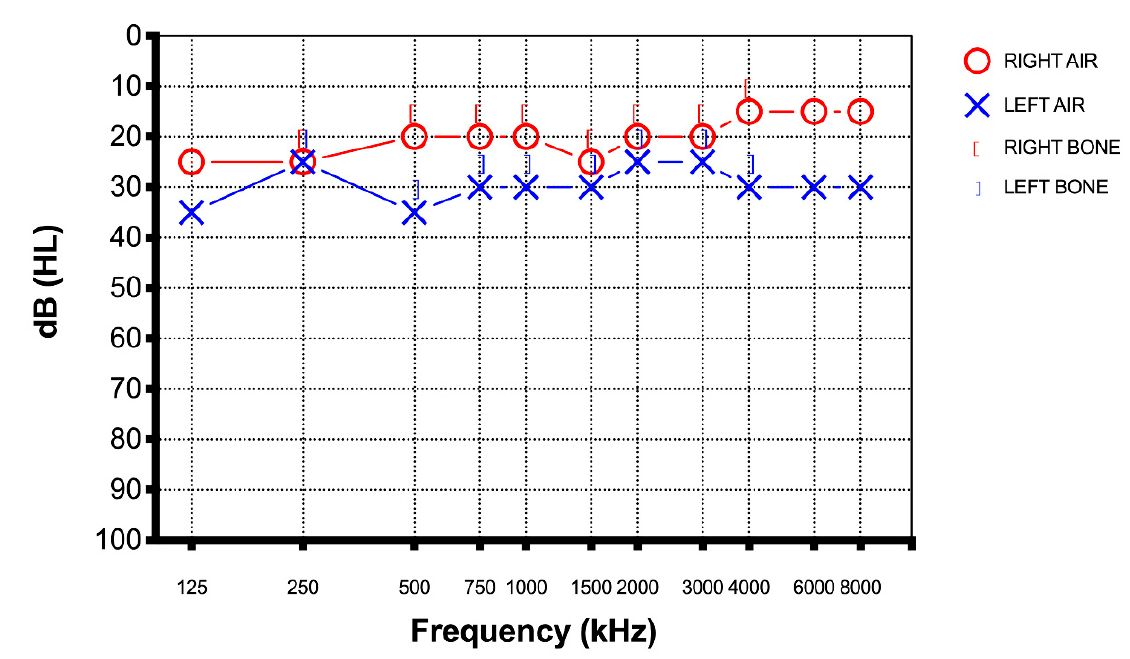
Figure 3. Case 1 pure tone audiometry after therapy showed a total recovery of the hearing loss.